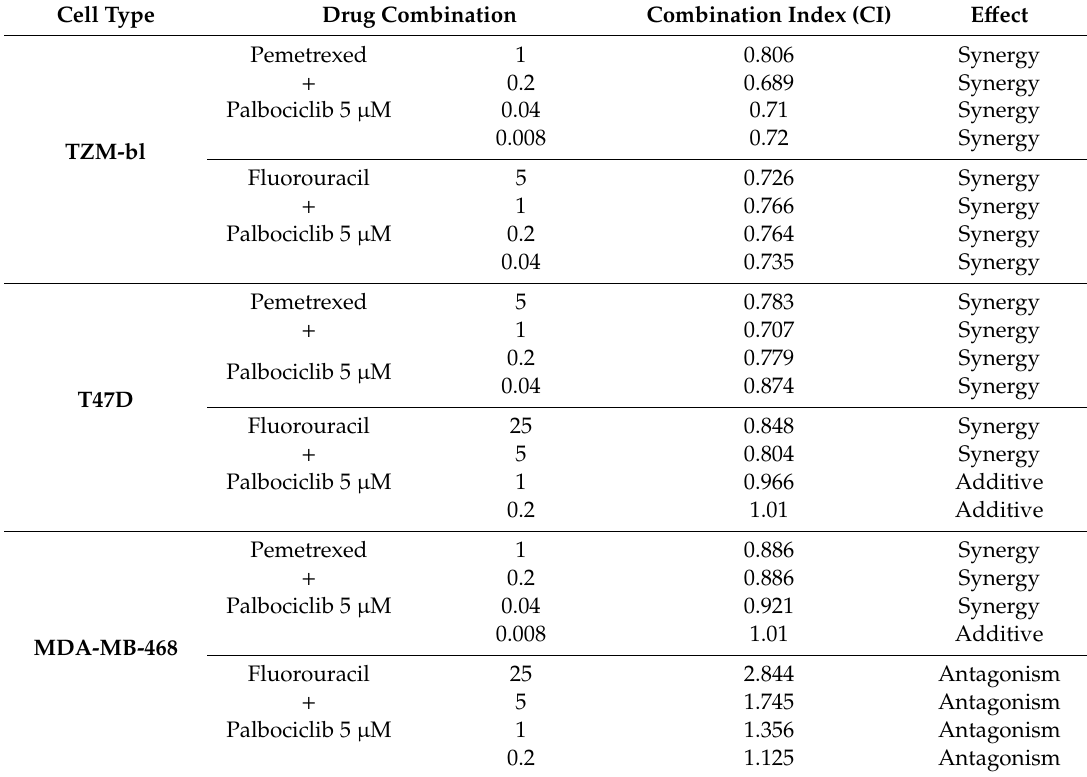
Table 3. Combination index values for pemetrexed and fluorouracil combinations with palbociclib. TZM-bl, MDA-MB-468 and T47D cells were treated with indicated concentrations of pemetrexed or fluorouracil in combination with 5 µ M of palbociclib. Cytotoxic e ff ect of the drugs was tested by MTT